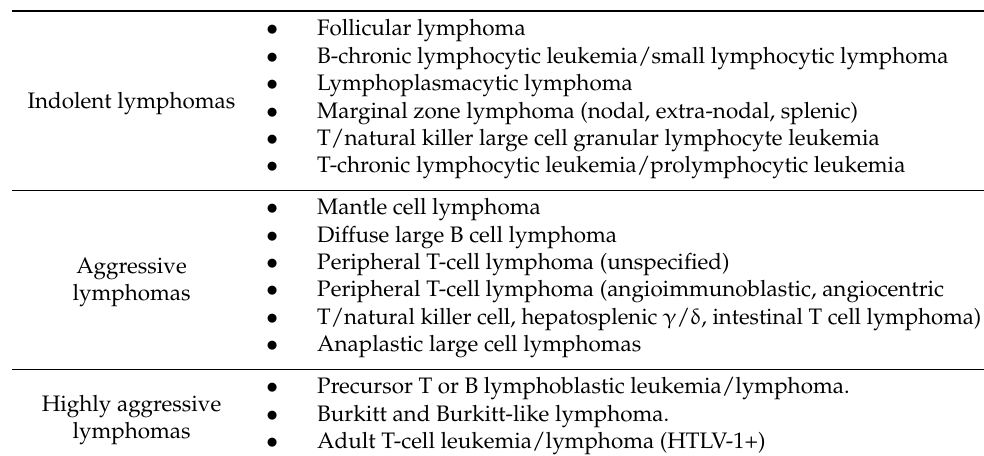
Table 1. Classification of